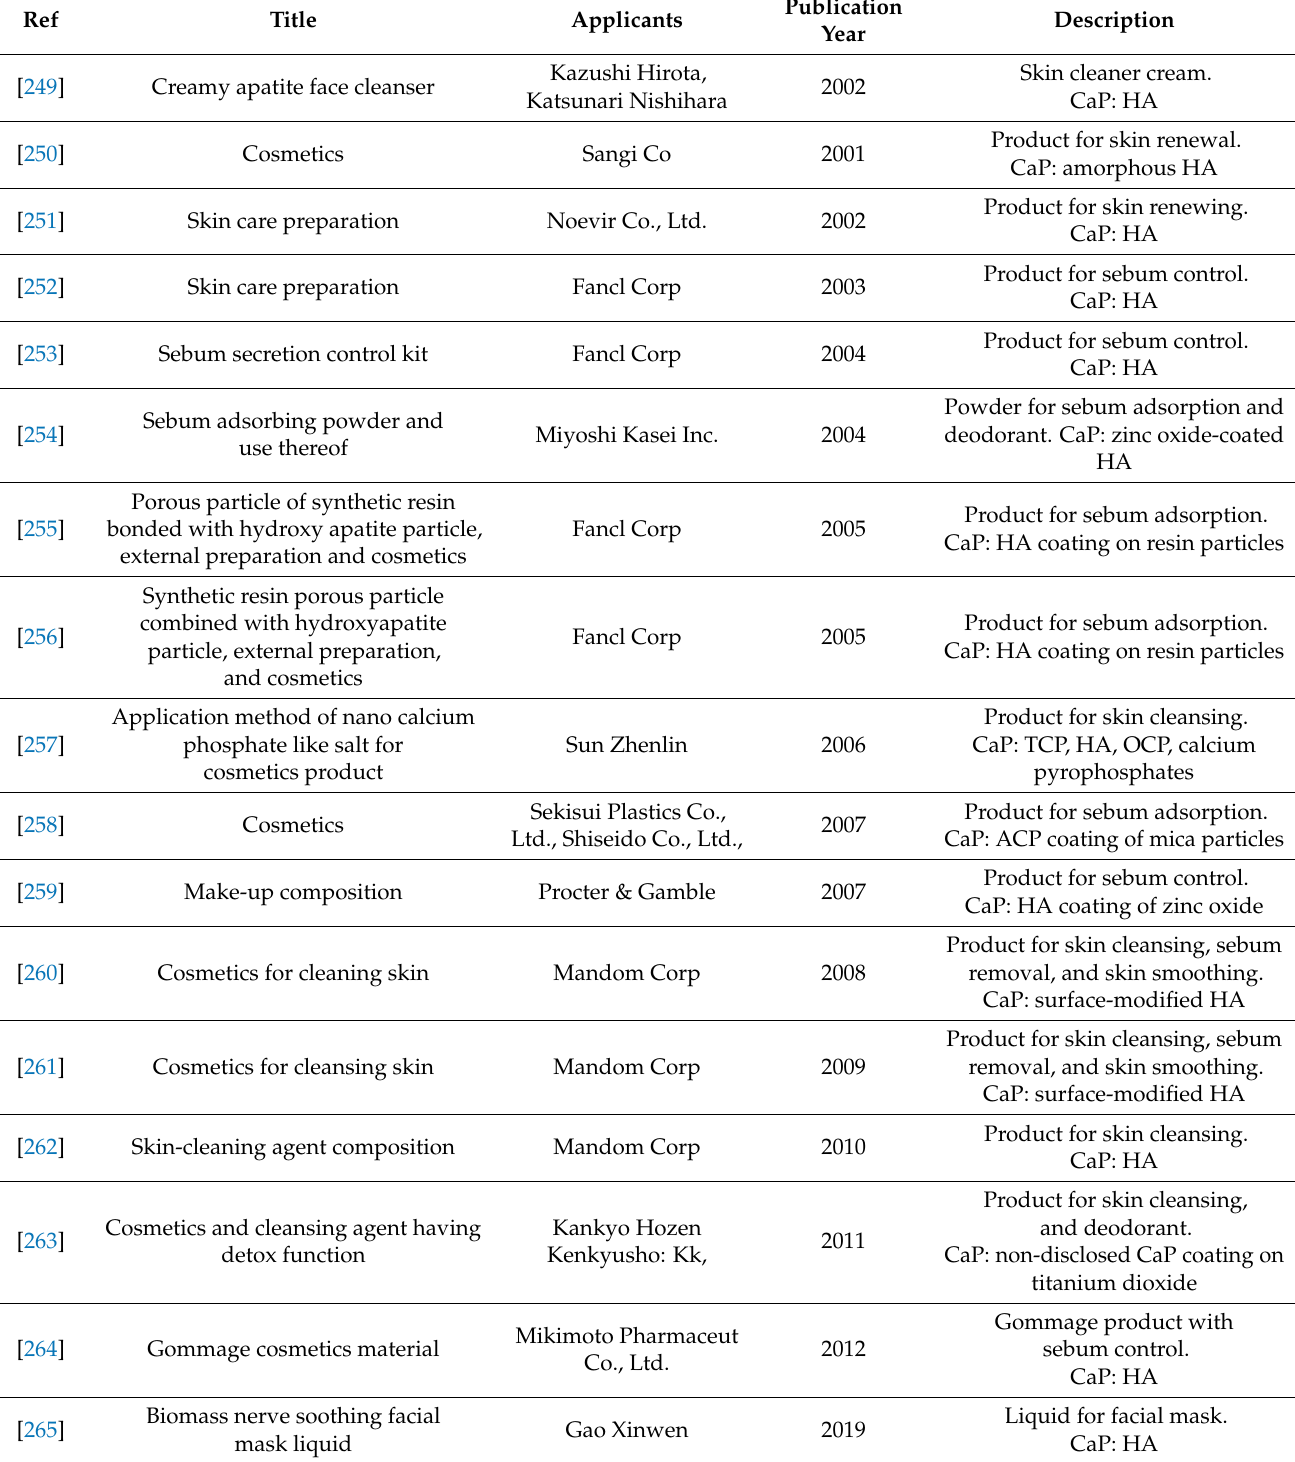
Table 4. List of patents about calcium phosphate as skin